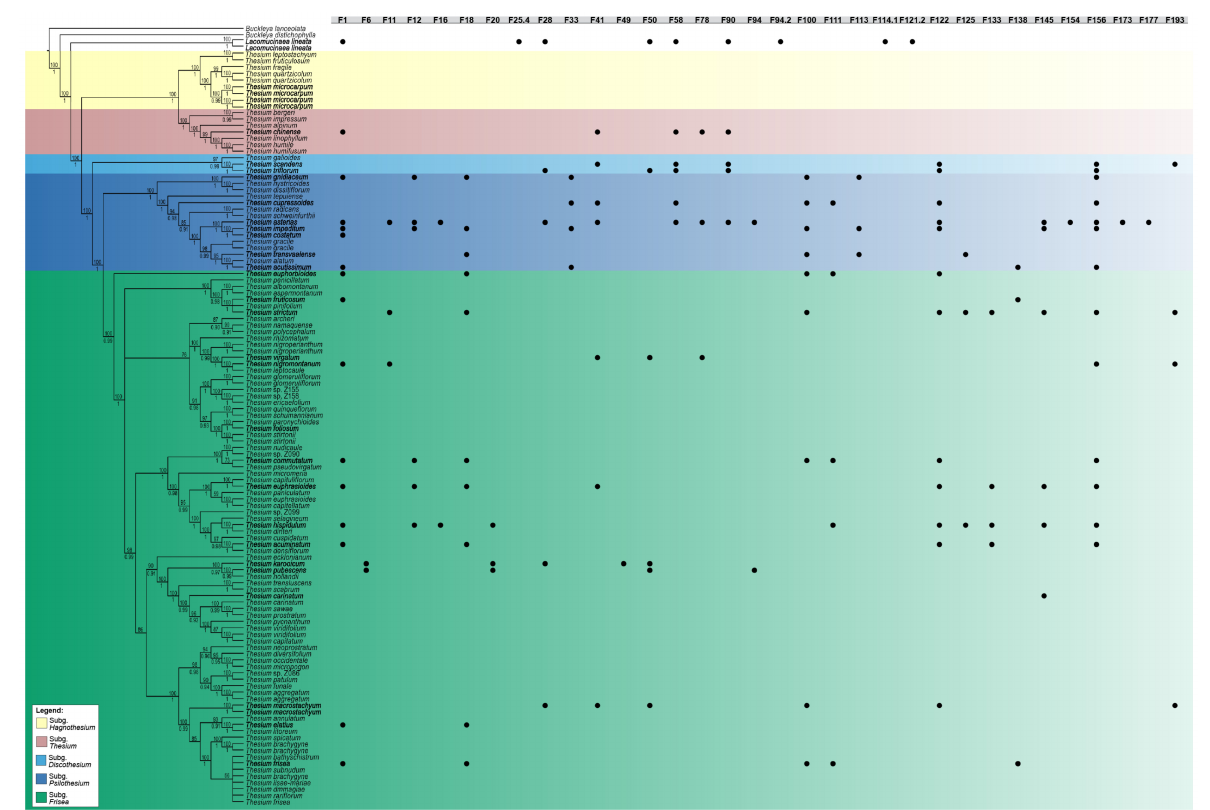
Figure 3. Patterns of phenolic compound variation observed in Thesium (27 species) and Lacomucinaea (1 species) within a phylogenetic framework. The most common phenolic compounds (peaks) de- tected in Thesium (see Table 2) and Lacomucinaea (see Table 3) are plotted on the most recent molecular phylogeny (adapted from [7]). The presence of compounds (peaks) in species is indicated with solid circles, and the five subgenera are shown in different colours. Compound names correspond with the information provided in Tables 2 and